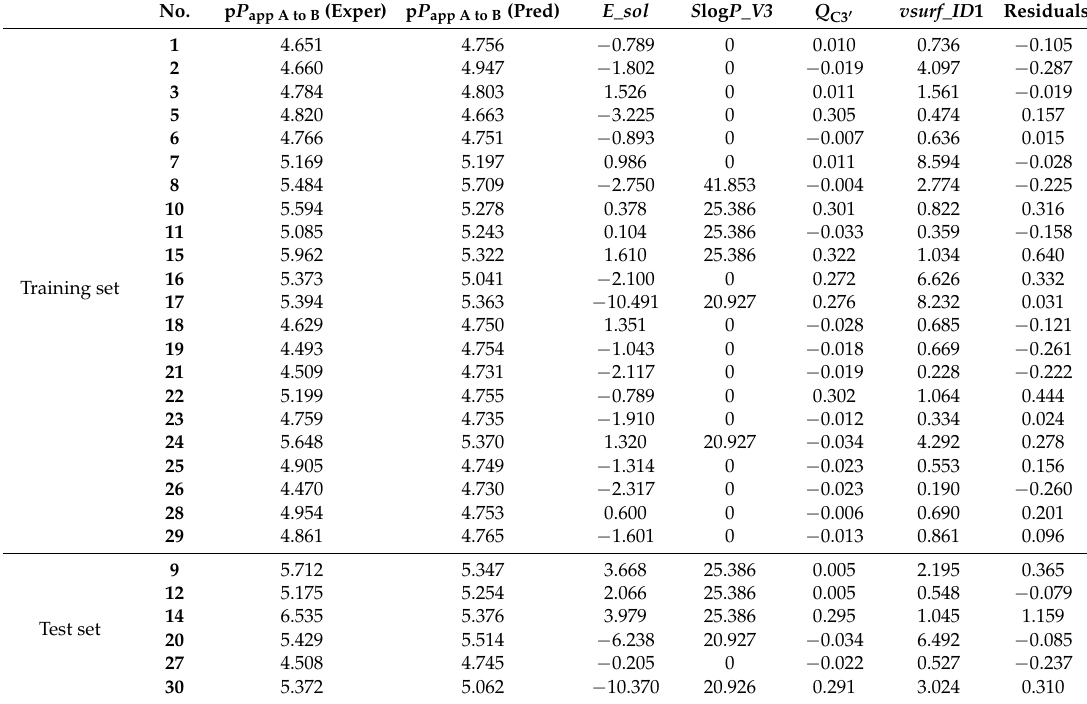
Table 7. Calculated results using the QSPR